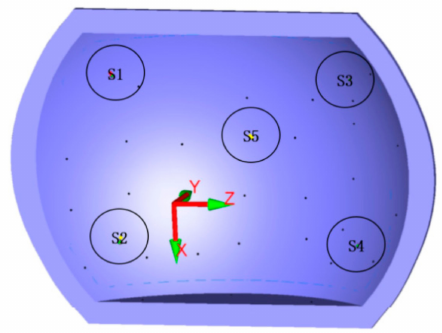
Figure 14. Target points in five areas on the grinding